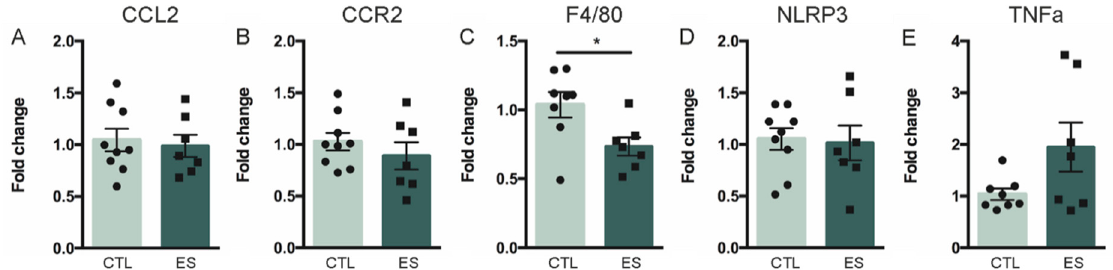
Figure 2. ( A – E ) effects of ES on adipose tissue inflammatory gene expression at P9. ES decreased expression of F4/80, a marker of macrophages. Data are presented as mean ± standard error of the mean (SEM); * effect of condition; p < 0.05.